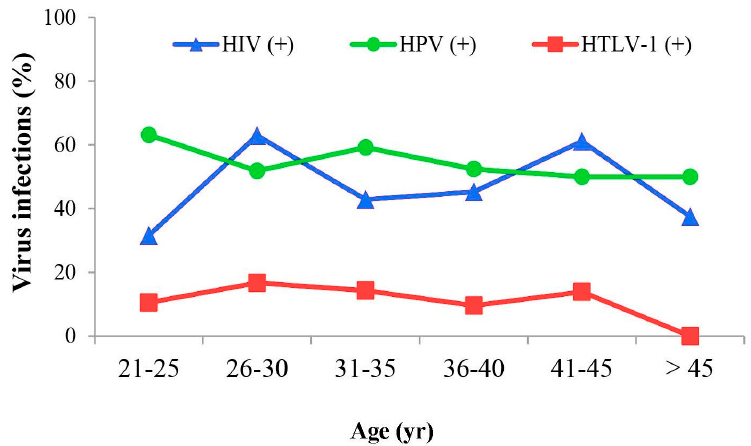
Figure 3. Relationship between HTLV ‐ 1, HPV, human immunodeficiency virus (HIV) infections and age. There was no significant difference observed between the median age of HTLV ‐ 1 positives with respect to either HPV or HIV status. However, there was a trend towards a lower HTLV ‐ 1 prevalence among women >45 years old when compared to women positive for HPV and HIV.